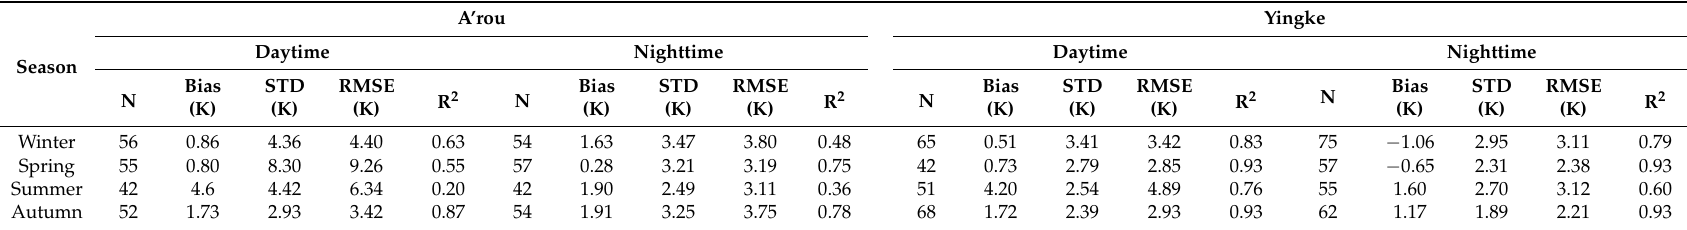
Table 3. Bias, standard deviation (STD), root mean square error (RMSE), and correlation coefficient R-squared of the AATSR-derived LST vs. in situ LST over A’rou and Yingke site for different seasons of 2007–2011. Only the winter includes the year of